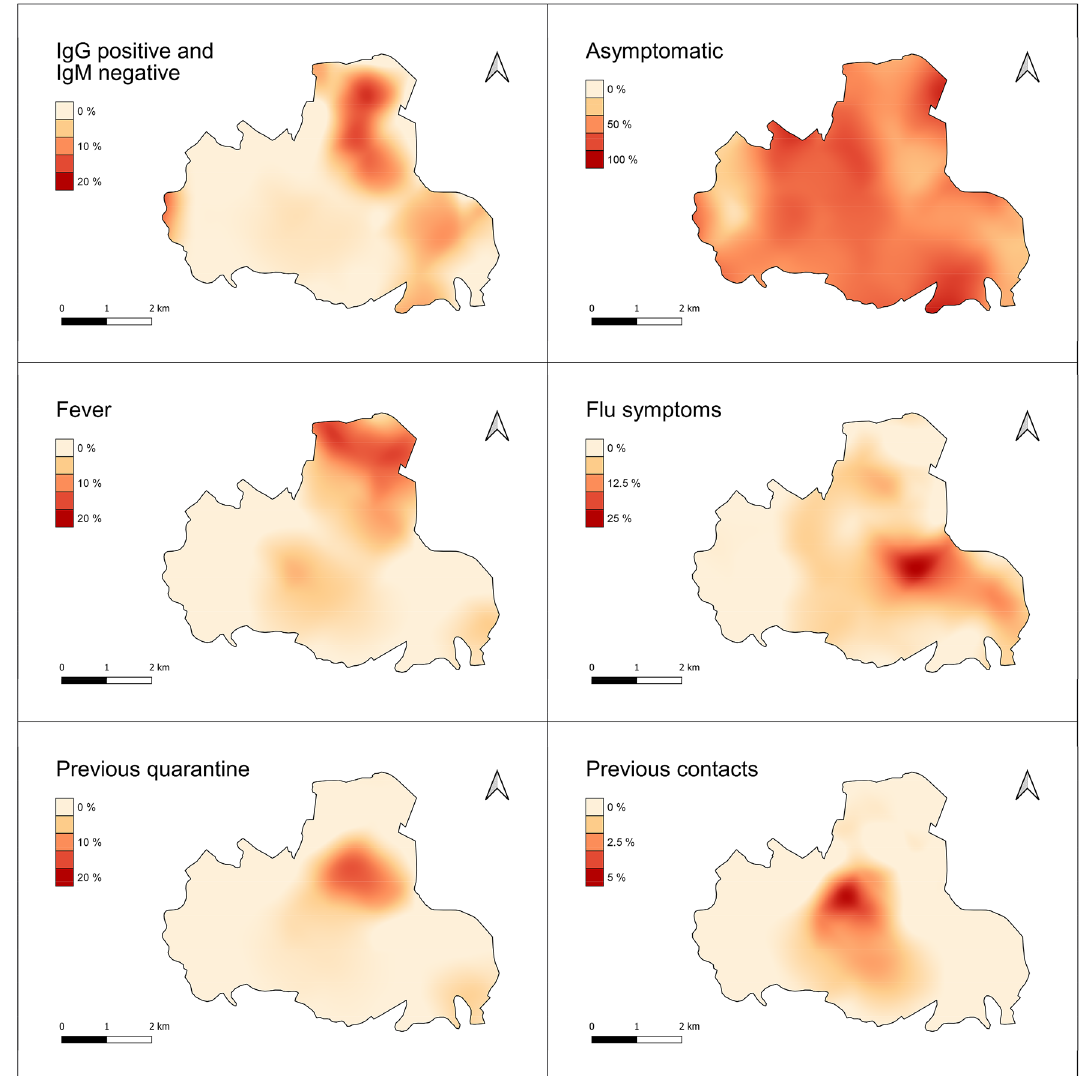
Figure 7. Maps showing the spatial distribution of the percentage of specific case groups relative to the tested subjects, per km 2 .